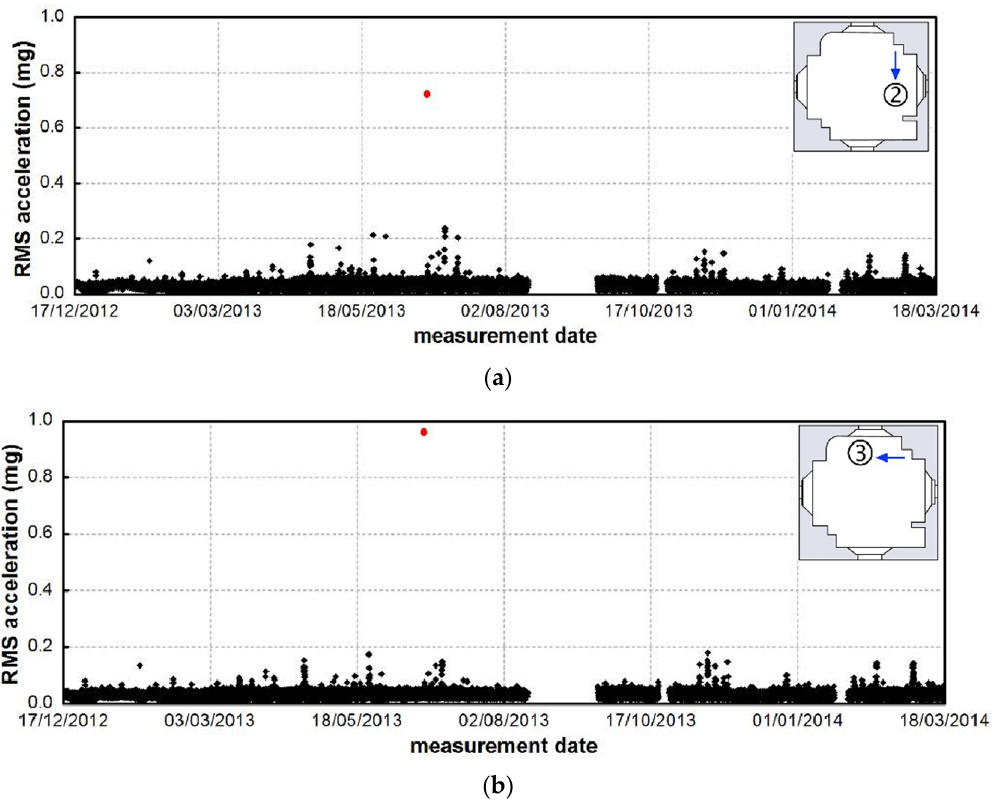
Figure 7. The root mean square (RMS) value of the acceleration measured on the tower at points 2 ( a ) and 3 ( b ) from 17/12/2012 to 17/03/2014 (the response to the seismic event of 21/06/2013 is marked in red).